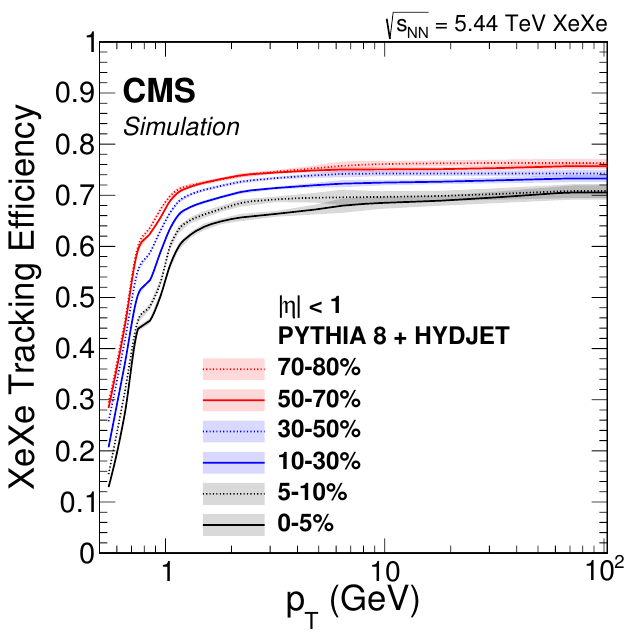
Figure 1 . The XeXe tracking e(cid:14)ciency for six centrality selections. The tracking e(cid:14)ciency at low- p T values decreases because of the strict track quality requirements used. Above p T = 3 GeV the e(cid:14)ciency for central events is rather (cid:13)at around 70%. The shaded bands show the statistical